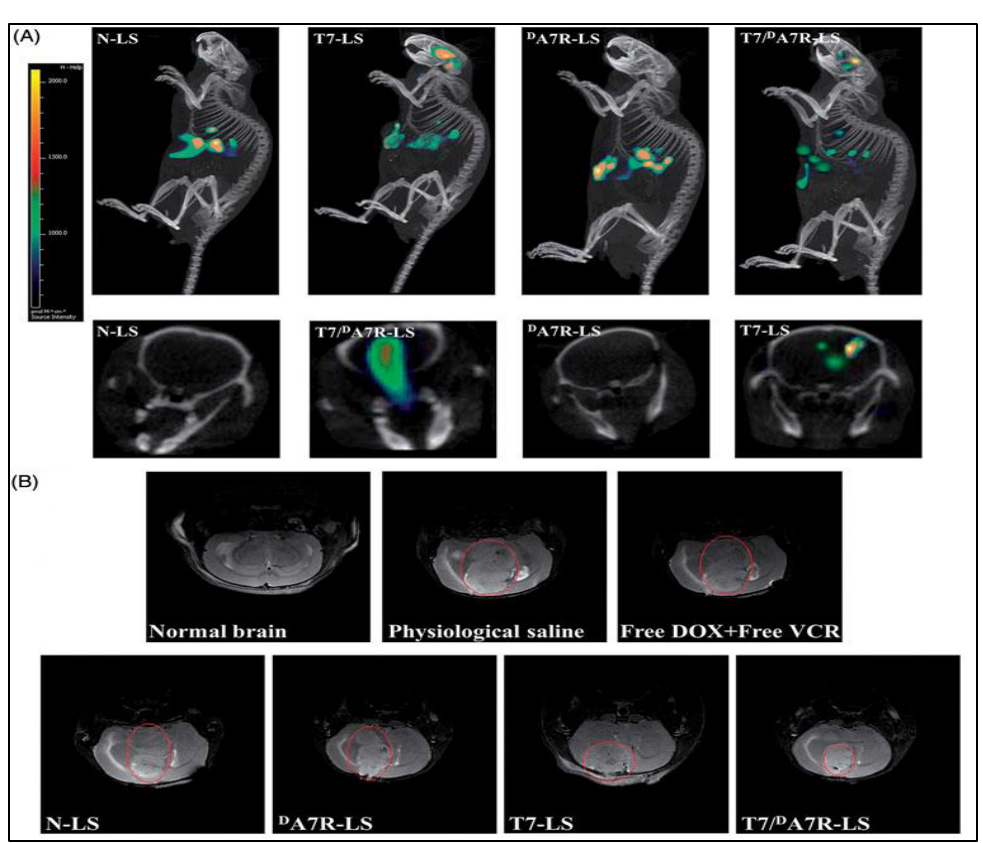
Figure 5. In vivo anti-glioma effect of doxorubicin (DOX) and vincristine (VCR)-loaded T7/ D A7R-LS immunoliposomes. ( A ) Distribution of Cy5.5 in the mice brain bearing intracranial C6 glioma determined by a CLSM; ( B ) MRI of normal and pathological brains at 16 d after inoculation. Reprinted from [129], Taylor and Fransis Group, 2017.